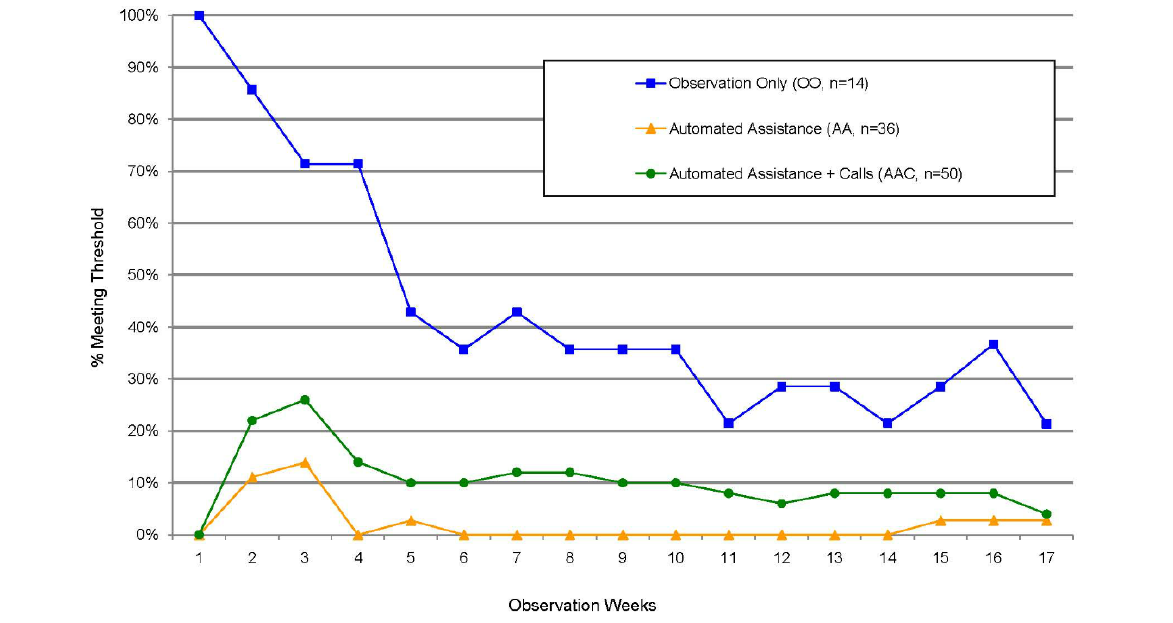
Figure 3. Percentage of participants, by group, meeting the self-monitoring threshold by week (N = 100). The prompting intervention occurred during weeks 2 and 3. The weekly threshold for self-monitoring was defined as tracking 1 or more behaviors 3 or more times during a week. AA = automated assistance group, AAC = automated assistance + calls group, OO = observation-only